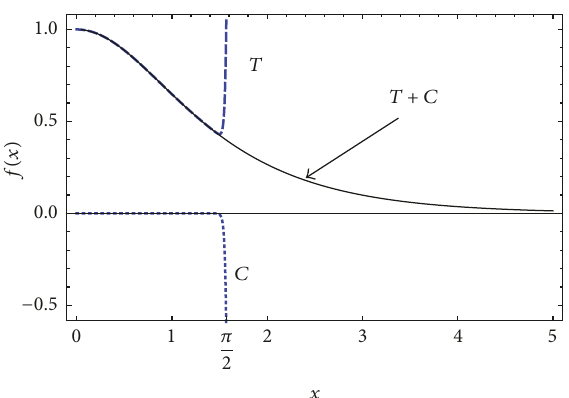
Figure 1: The solid curve corresponds to the convergent power seriesobtainedbythepresentmethodasgivenby(12) using 𝑛 max = 4 and 𝑁 = 100 . It is indistinguishable from the solid curve of 𝑓(𝑥) = sech (𝑥) . Dashed curve corresponds to the Taylor series expansion, 𝑇 , and the dotted curve corresponds to the complementary series, 𝐶